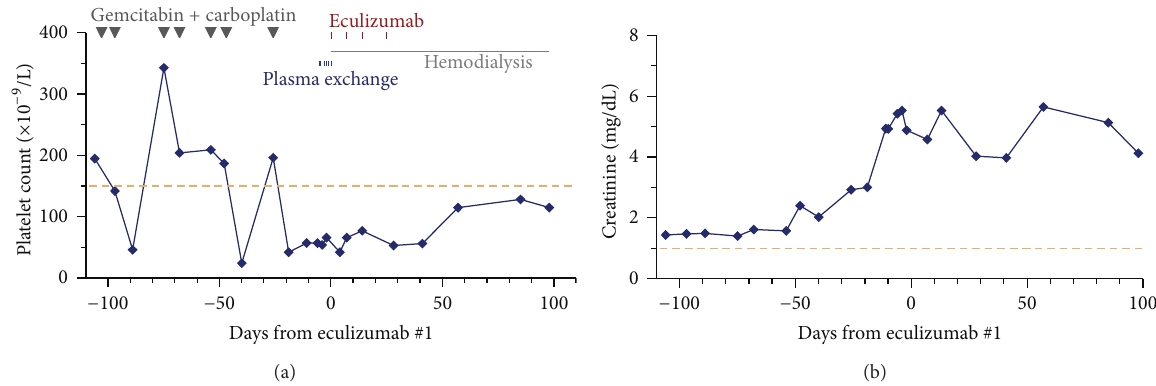
Figure 2: Development of thrombocytopenia and renal failure in a patient of metastatic cholangiocarcinoma treated with gemcitabine and carboplatin and the lack of response to eculizumab therapy. Neither plasma exchange nor eculizumab therapy increased the platelet counts or improved the renal function of this case. The thrombocytopenia induced by chemotherapy was transient before renal failure occurred. Thus, the lack of platelet response to eculizumab therapy was not due to bone marrow suppression by chemotherapy. The dashed lines mark the lower limit of normal platelet count and the upper limit of serum creatinine, respectively.